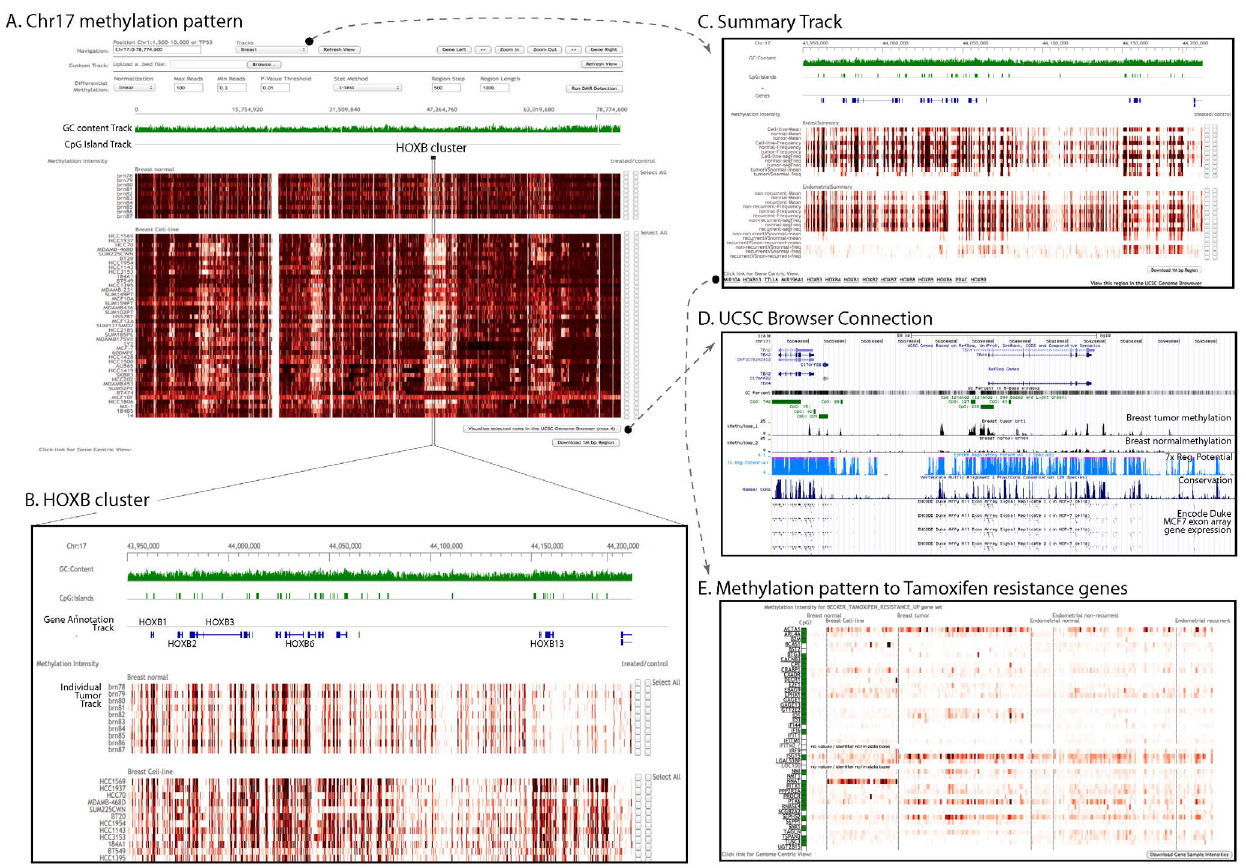
Figure 1. Genomic view of CMS. This webpage is designed for the genome-wide visualization and analysis of methylation intensity (A, B, C). Methylation intensity is pre-calculated for a 100 bp bin size and is shown using a red gradient heatmap. A variety of genomic annotations and functional toolbars give users more options in browsing the webpage. Statistical methods were imbedded, including DMR analysis (A) and statistical calculation (C). Links to UCSC genome browser (D) and to gene view (E) are available for further analysis.